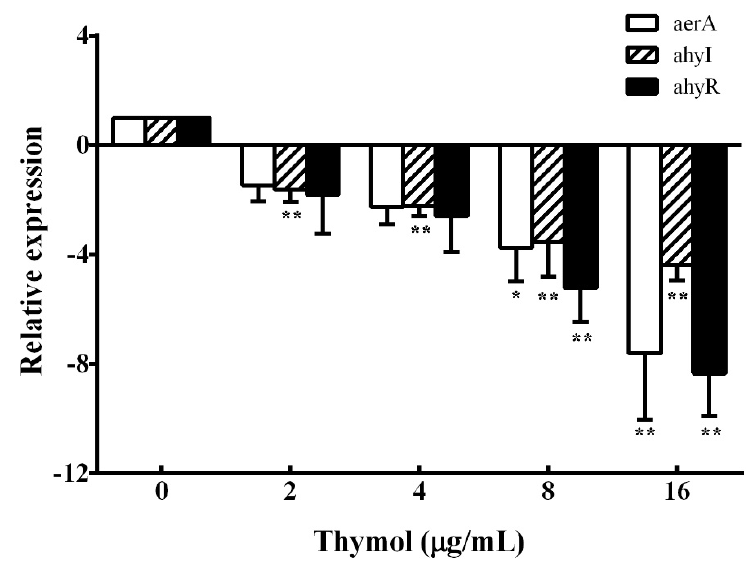
Figure 5. Relative expression of aerA , ahyI , and ahyR genes in A. hydrophila was determined by real-time PCR after treatment with indicated concentrations of thymol. All samples were analyzed in triplicate and data are shown as mean value ± SD. *, p < 0.05 and **, p < 0.01 when compared with the drug-free supernatants.